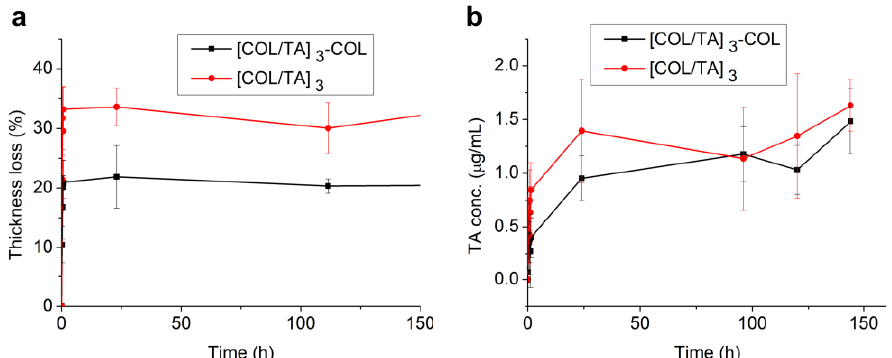
Figure 3. Stability of COL/TA films and TA release. ( a ) Thickness loss of non-dried films on silicon measured by ellipsometry in the dry state and ( b ) concentration of TA released from non-dried films deposited on glass slides and put in contact with a physiological medium.